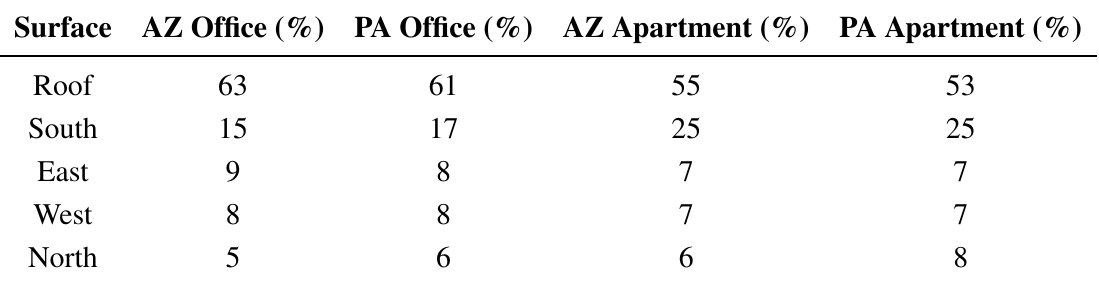
Table 7. Simulation results for local power derived as annual PV gains, reported as a percent contribution to the net solar electric energy production in the